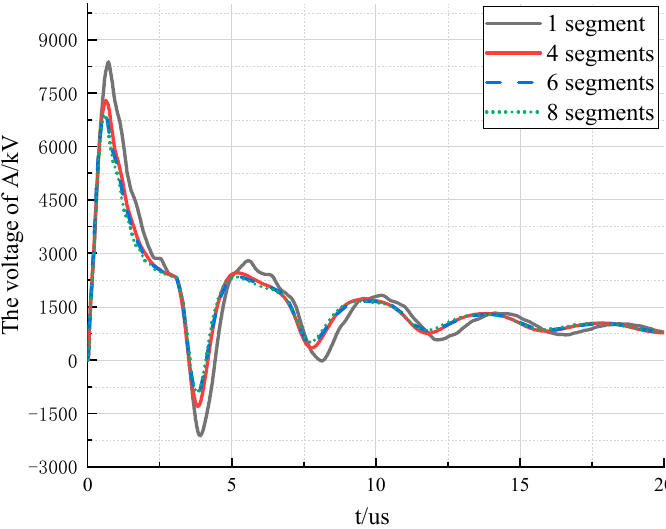
Figure 9. Simulation results of the voltage for multi-segment multi-surge impedance model.